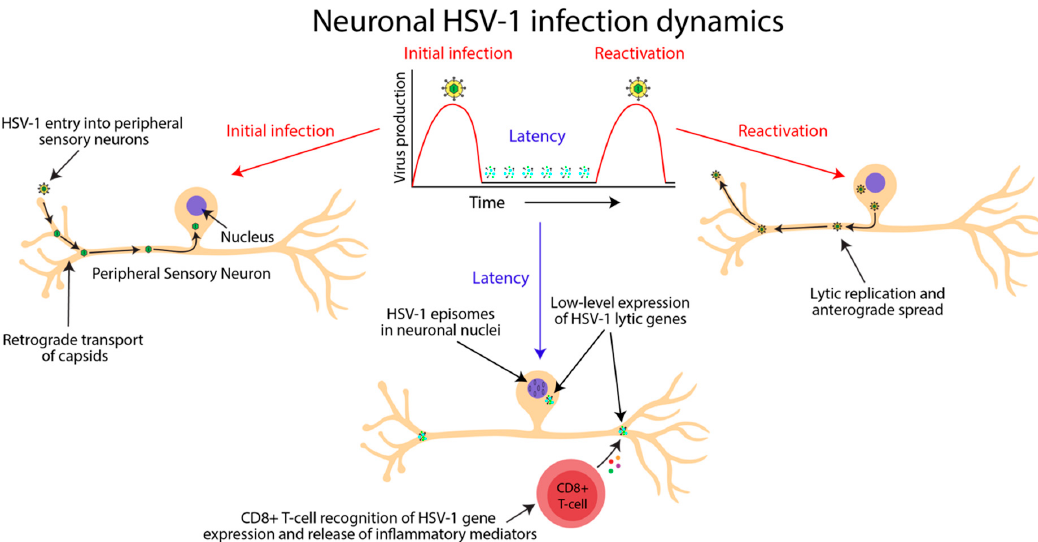
Figure 2. Persistent herpes simplex virus 1 (HSV-1) infection has periods of latency interspersed with periods of reactivation. The definition of latent viral infection requires a lack of infectious virus production between periods of active lytic replication. Infectious virions enter the nervous system at sensory nerve endings from the site of initial infection and are trafficked in retrograde to neuronal nuclei within peripheral ganglia. Within the neuronal nuclei, HSV-1 genomes form episomes, and lytic replication is repressed. However, during this time, low levels of lytic gene expression occur in the absence of infectious virion production, inducing local immune responses to dampen viral gene expression. Upon reactivation, infectious virions are produced and are trafficked in an anterograde direction back to the site of infection, causing recurrent skin infection and transmission to new hosts. The lack of infectious virion production and the formation of episomal DNA within host neuronal nuclei demonstrates that HSV-1 is not a chronic infection (i.e., with constant low-level virus production), despite its ability to produce low levels of lytic gene expression during latency. Diagram: neuronal cell cartoons from BioRender.com, graphical representation of HSV-1 infection dynamics adapted from [60].